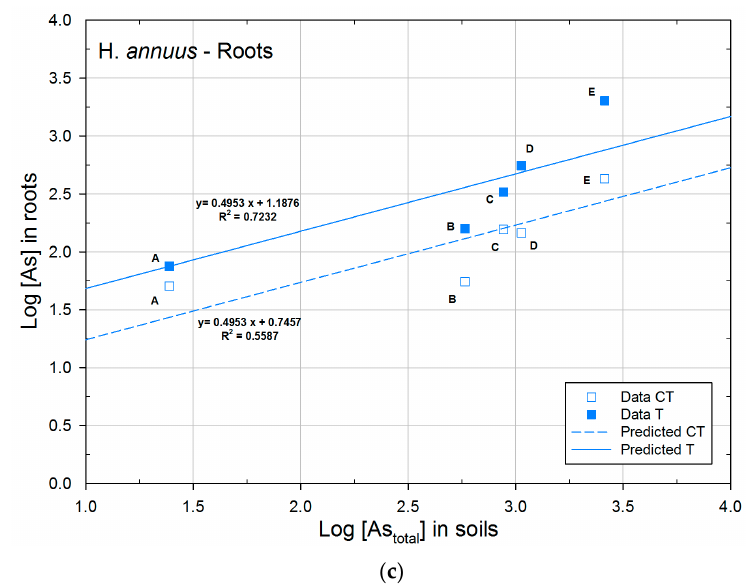
Figure 3. Freundlich-like equation for the root uptake of B. juncea ( a ), L. albus ( b ), and H. annuus ( c ) in control (CT) and phosphate treated (T) soils. Table 3. Relationship between root uptake and As concentration in soil. Parameters of the Freundlich-like model by setting 1/ n as shared parameter.